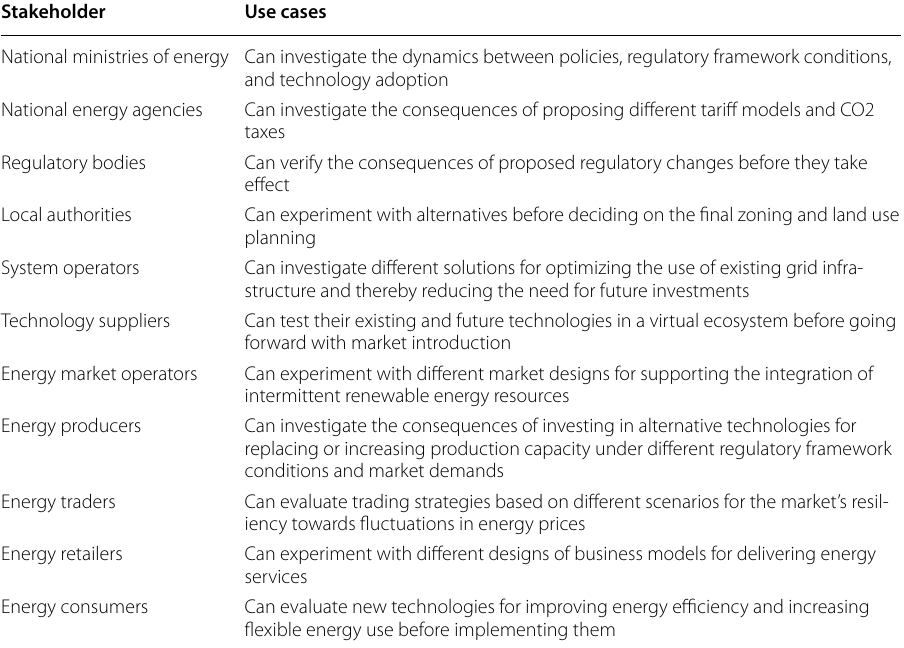
Table 2 Individual stakeholder’s use cases for the energy ecosystem Stakeholder Use cases National ministries of energy Can investigate the dynamics between policies, regulatory framework conditions, and technology